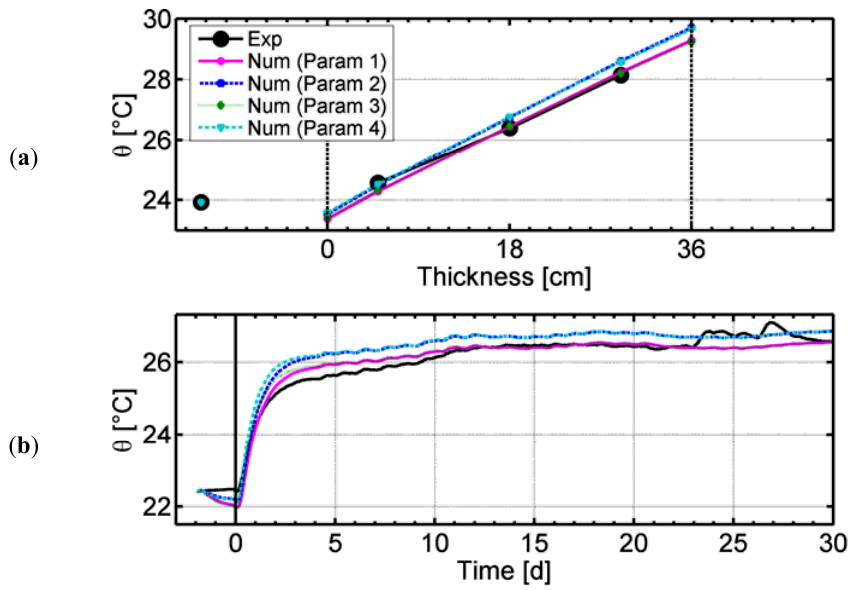
Figure 11. Sensitivity analysis (colored lines) to the thermal properties (see Table 3) and comparison to experimental results (black lines). Top graph ( a ) shows the spatial response at t = 15 d; bottom graph ( b ) the transient response at x = 18 cm.